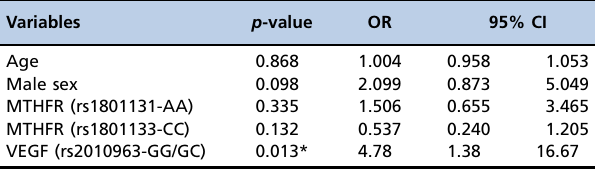
Table 6 - Logistic regression analysis to predict the occurrence of multinodular tumors in 117 Brazilian patients with HCV-related